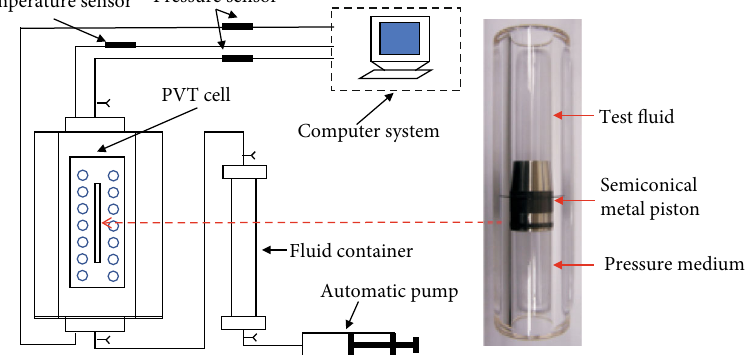
Figure 1: Schematic of the experimental setup for the property tests of the CO